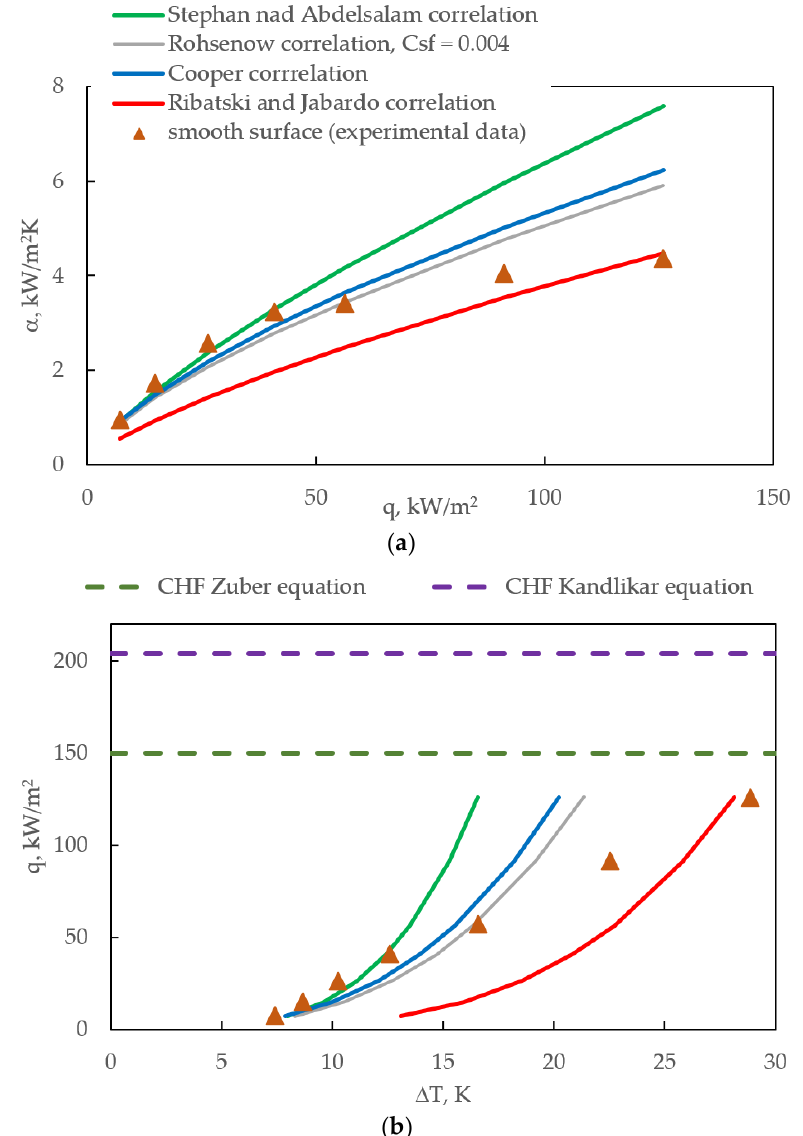
Figure 9. Comparison of pool boiling curves for 0.3 mm wide microchannels with boiling curves from surfaces with microparticle coating (MPC) [25], nanoparticle coating (NPC) [25] and mi- chemical oxidation [38].